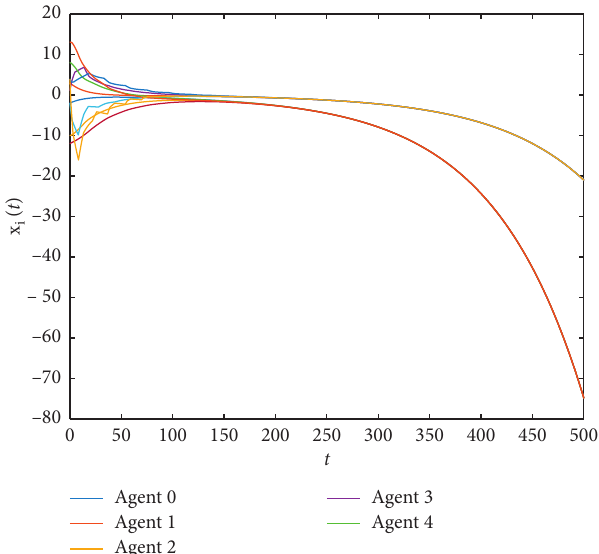
Figure 1: The states for tracking control.